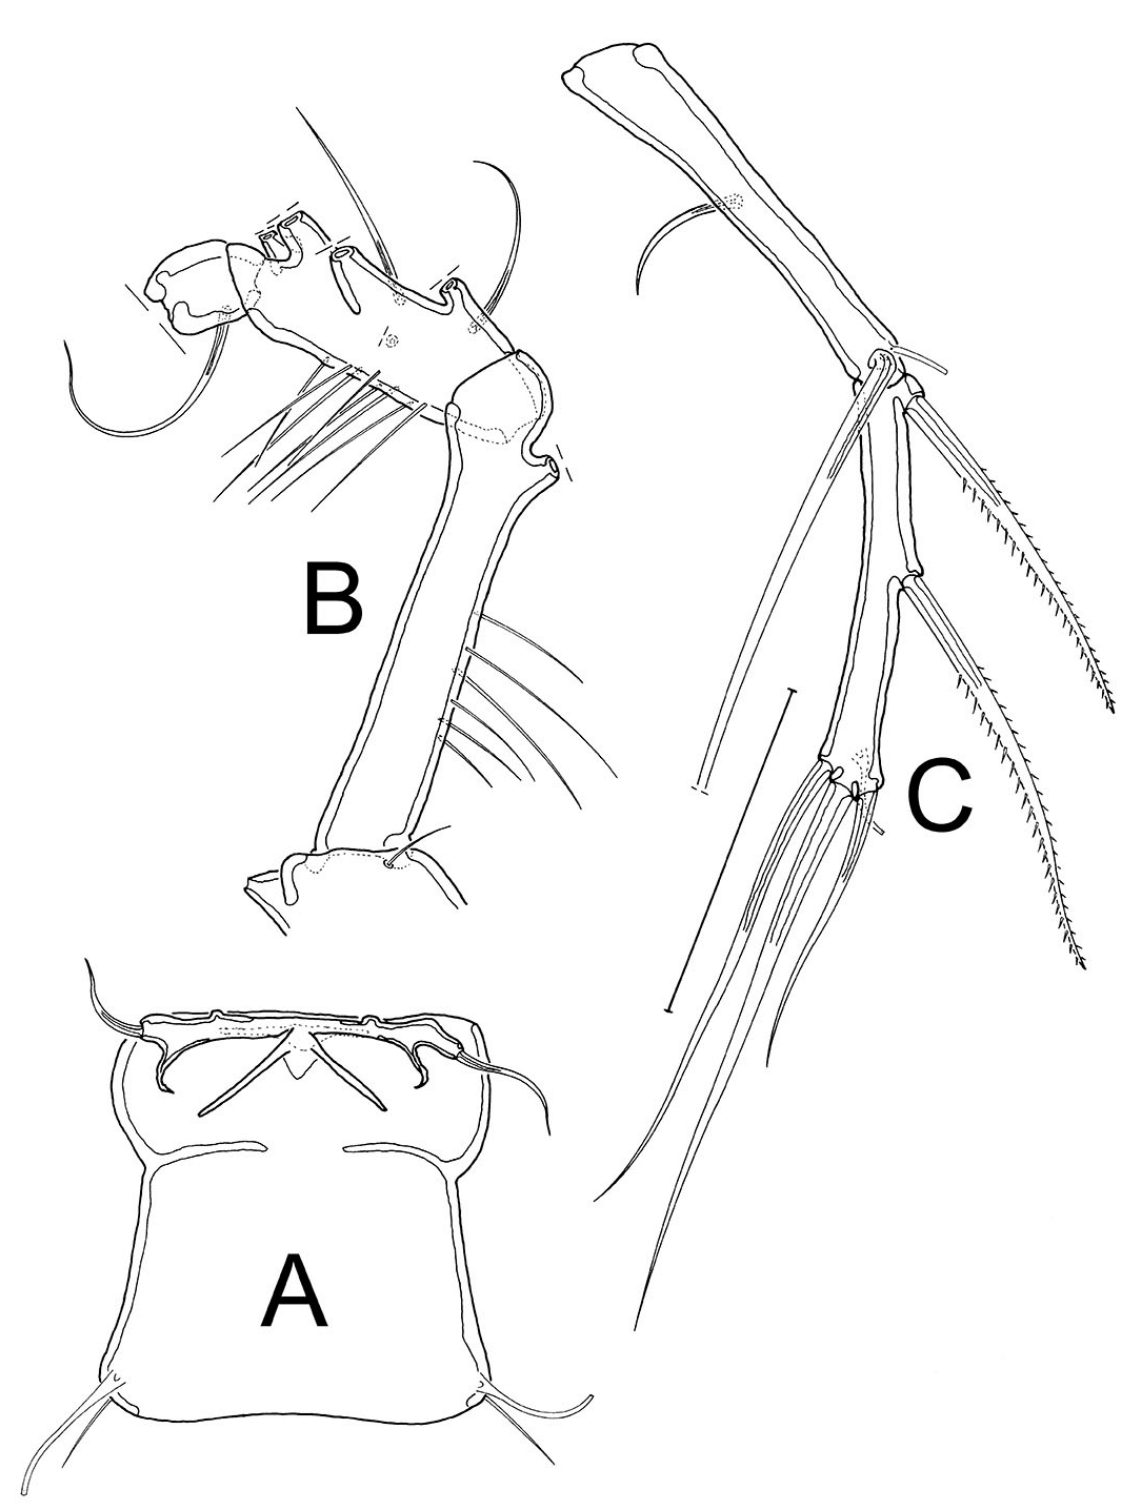
Fig. 7. Poropsyllus menzelae gen. et sp. nov. A . Female holotype (HUJ INVCRUCOP808), genital double somite with genital field and P6. B . Male allotype (HUJ INVCRUCOP809), A1, showing the first 3 segments. C . Male allotype, P5. Scale bar: 50